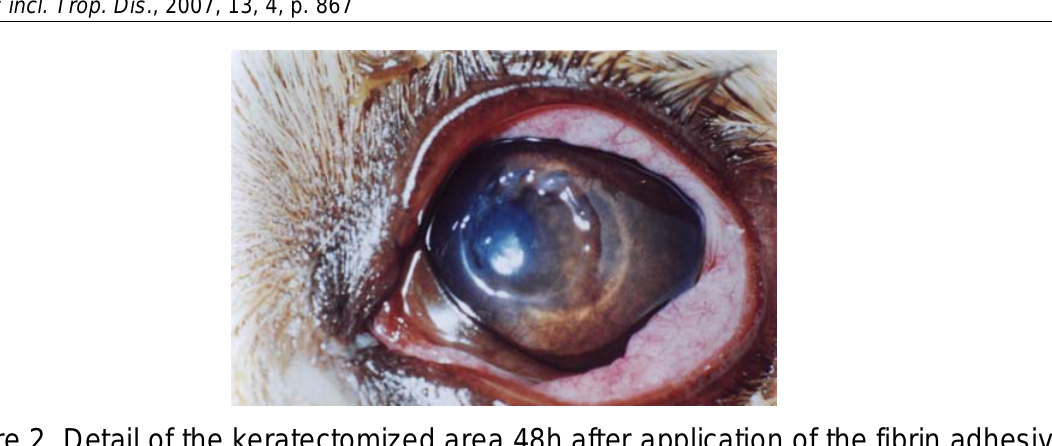
Figure 2. Detail of the keratectomized area 48h after application of the fibrin adhesive derived from snake venom in an animal of Group 2. There are fibrin adhesive residues on the keratocomized area, which does not show edema and is in an advanced stage of reepithelization.